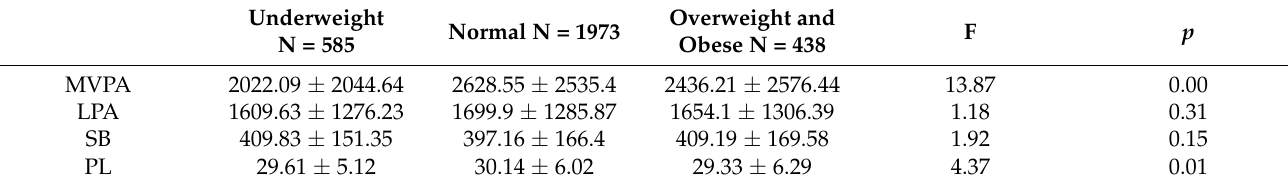
Table 3. Differences between groups with different weight status